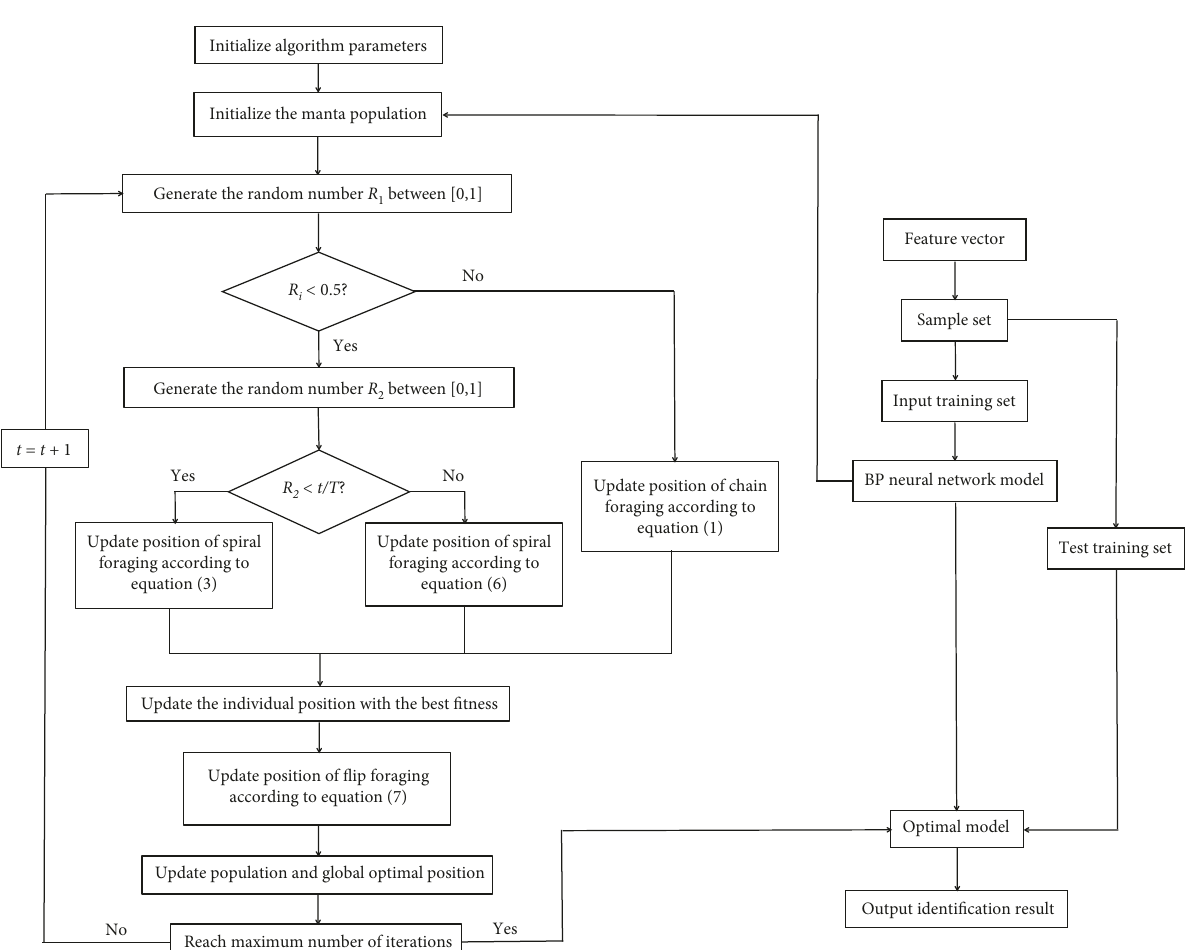
Figure 8: Flow chart of MRFO-BP neural network